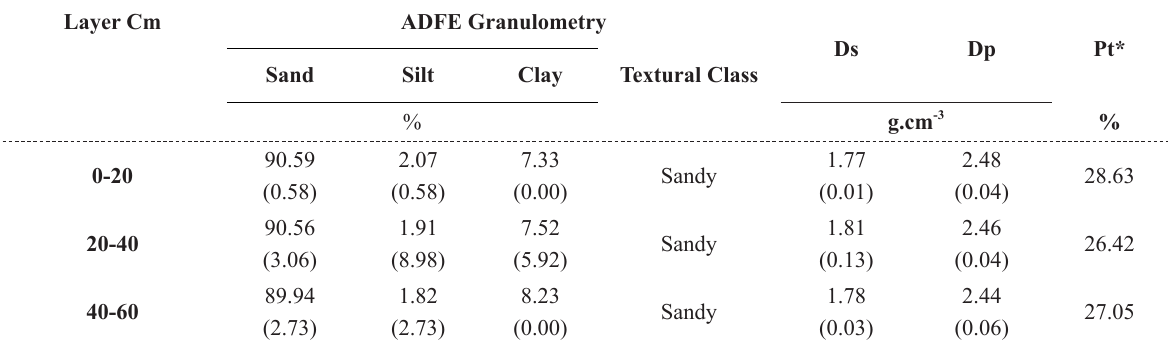
Characterization of the physical attributes of the psamitic dystrophic YELLOW LATOSOL, Sub-evergreen Forest phase with gently undulating